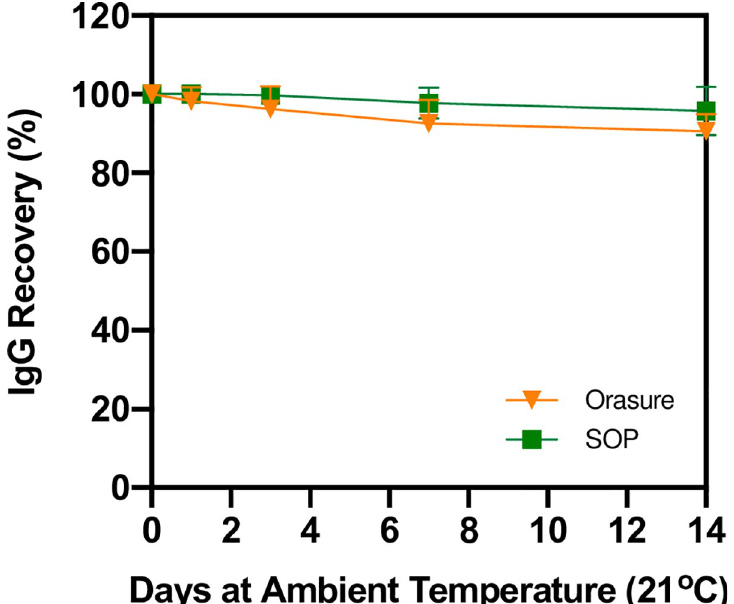
Fig 5. Stability study performed on spike-in of SARS-CoV-2 IgG into healthy saliva specimen using two different methods (a research SOP which involves expectoration into a falcon tube and the Orasure ™ Oral Fluid collection device). The collect saliva was aliquoted and left at ambient temp for 0, 1, 3, 7, 14 days. Results were normalized relative to the measured assay signal of a sample at day 0. Results show that the sample is stable with no significant degradation for up to 14